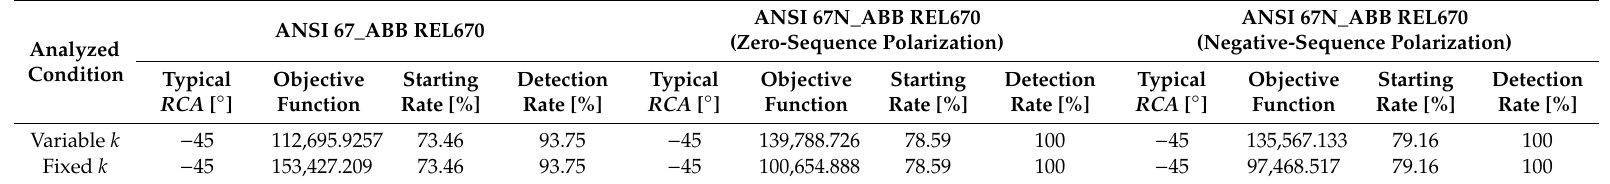
Table 4. Obtained results for the REL670 relay at LT_1 SE_A and typical RCA.